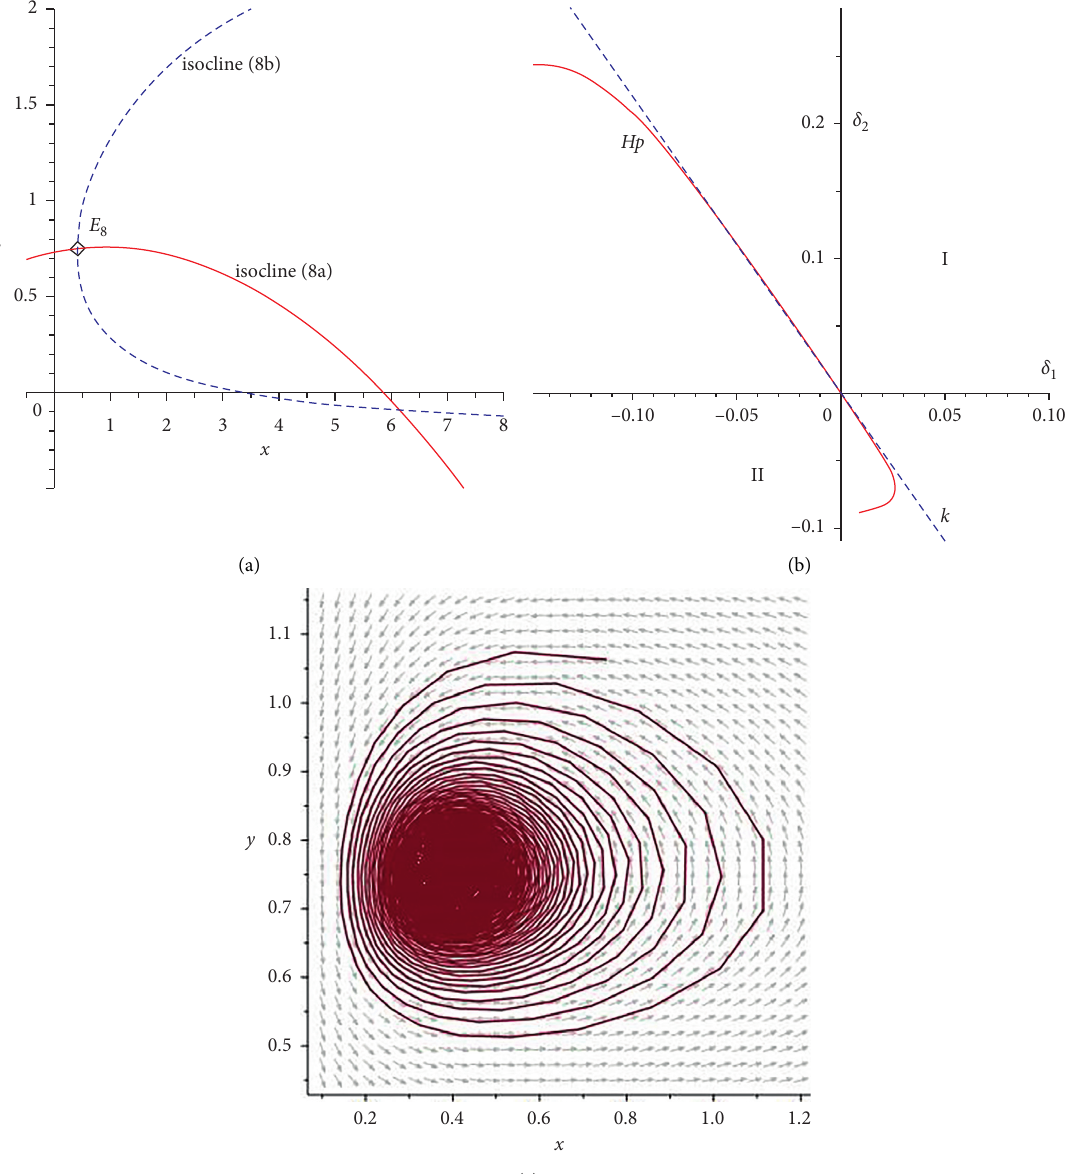
Figure 2: Figures in Example 1. (a) Existence of interior equilibrium E bifurcation curve Hp (in red). (c) A stable focus with d � 0 .